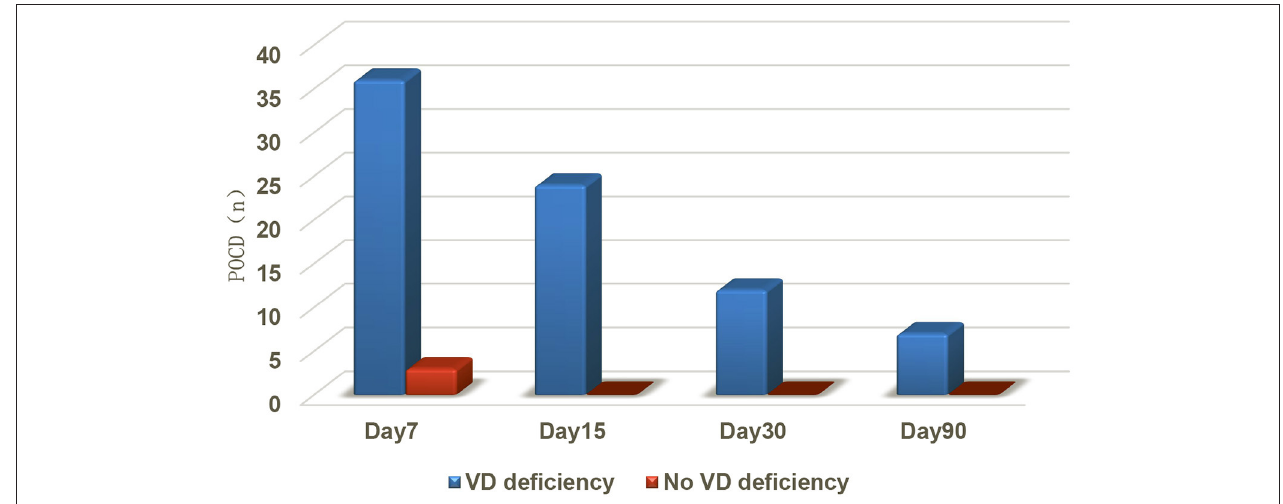
FIGURE 2 | Comparison of the number of patients with POCD between the two groups.